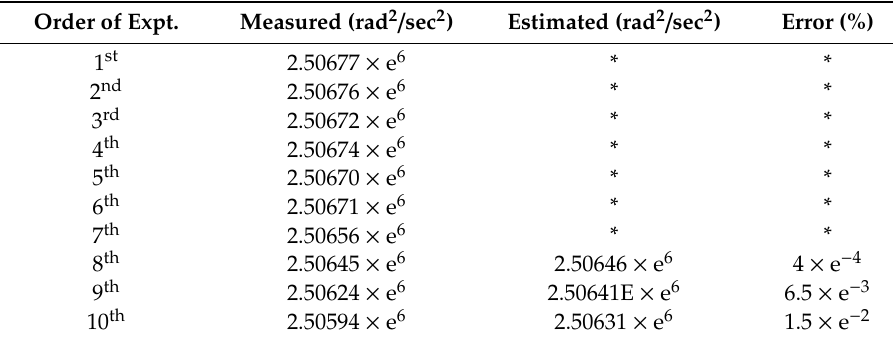
Table 4. List of ω 2 n in every